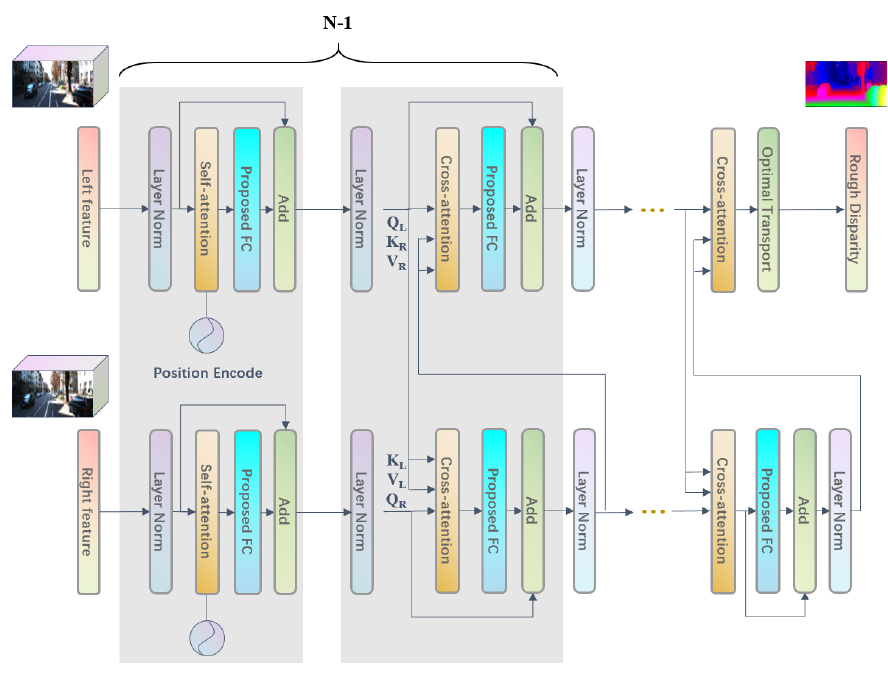
Figure 7. Transformer based on